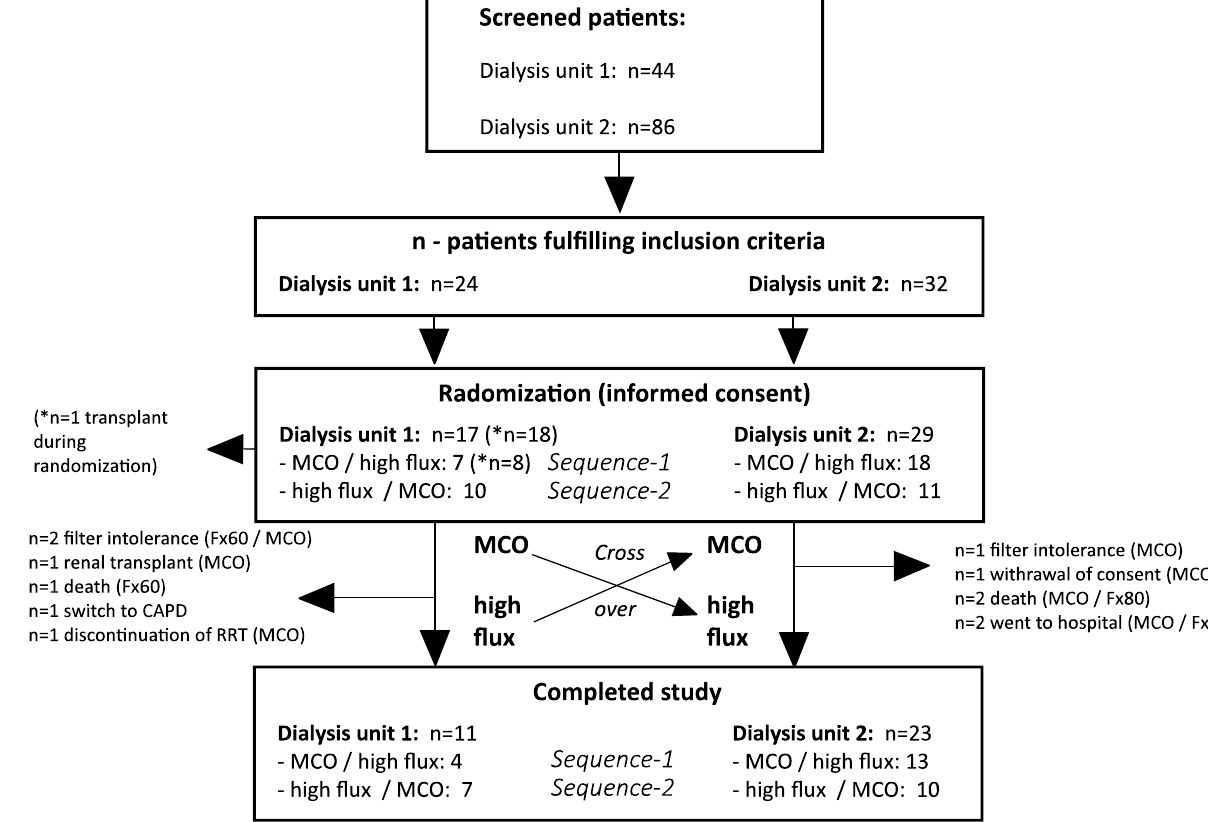
Figure 1. The flow chart shows patient recruitment and inclusion in two participating dialysis units [1: Klinikum rechts der Isar; 2: MVZ KfH Dachau]. Reasons for dropouts are displayed next to horizontal arrows ( → ). After all, a total of 34 patients completed the whole cross over